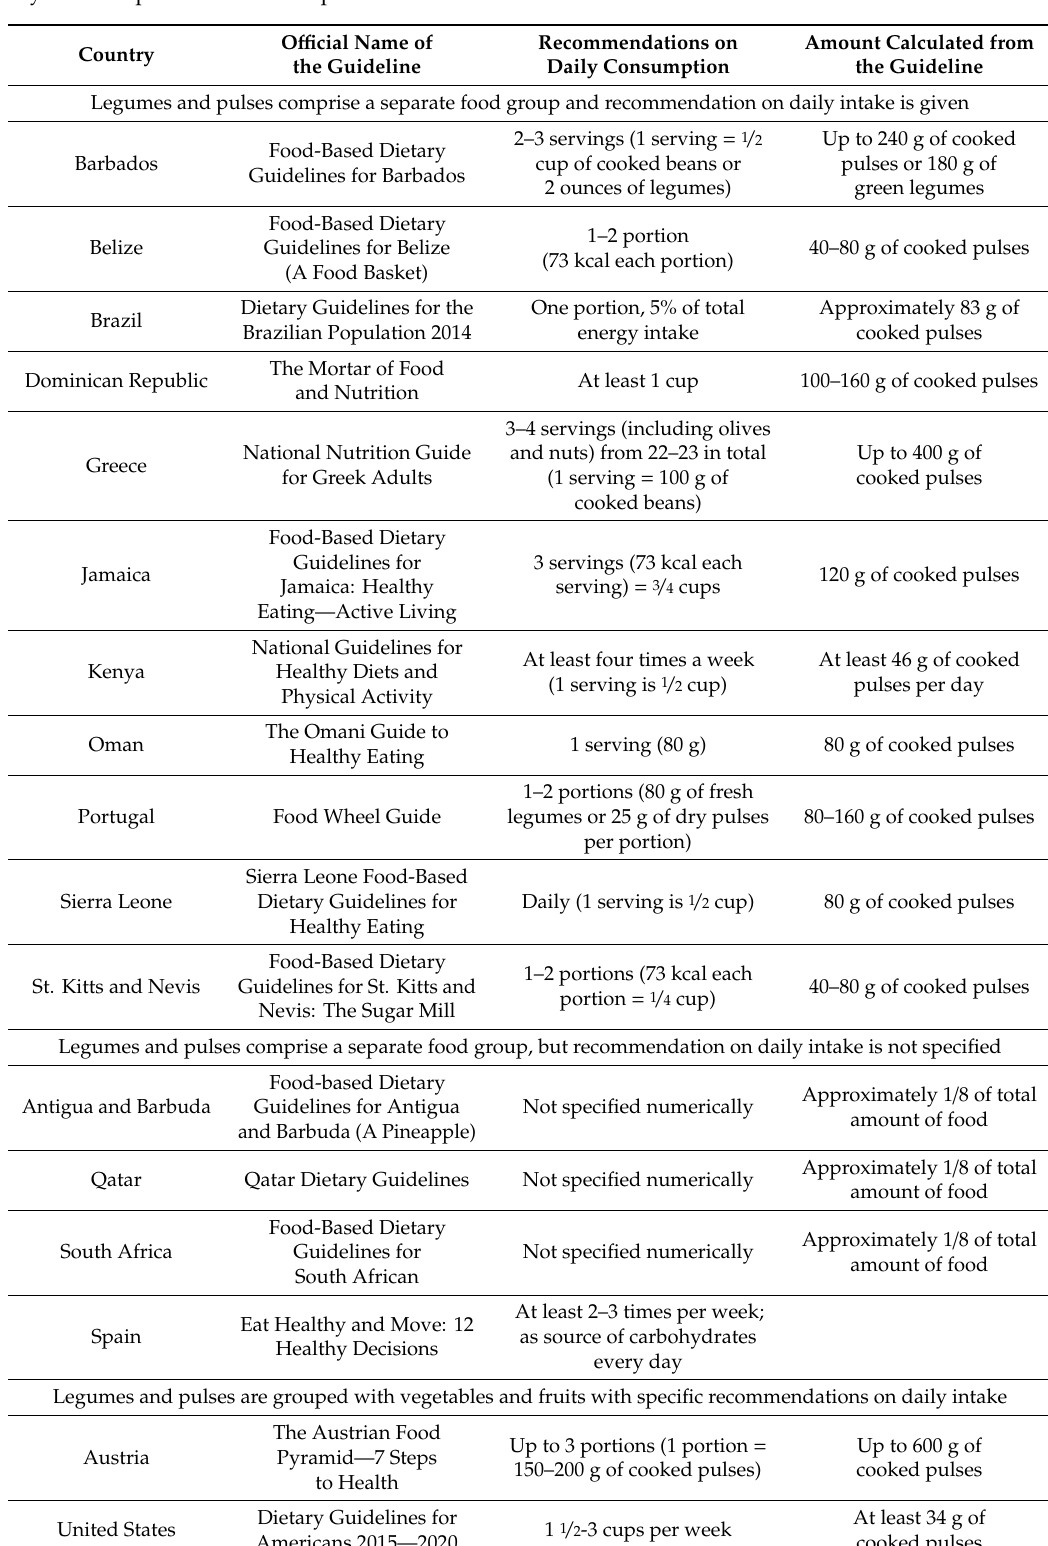
Table 1. Official recommended dietary consumption of pulses and legumes in an international comparison (information retrieved from the Food and Agriculture Organization of the United Nations [86]). For the calculation of the daily amount retrieved from the respective guideline, it was assumed that 100 g of cooked pulses refer to 120 kcal, 1 cup equals 160 g of cooked beans, peas or lentils and one portion of dry yields two portions of cooked